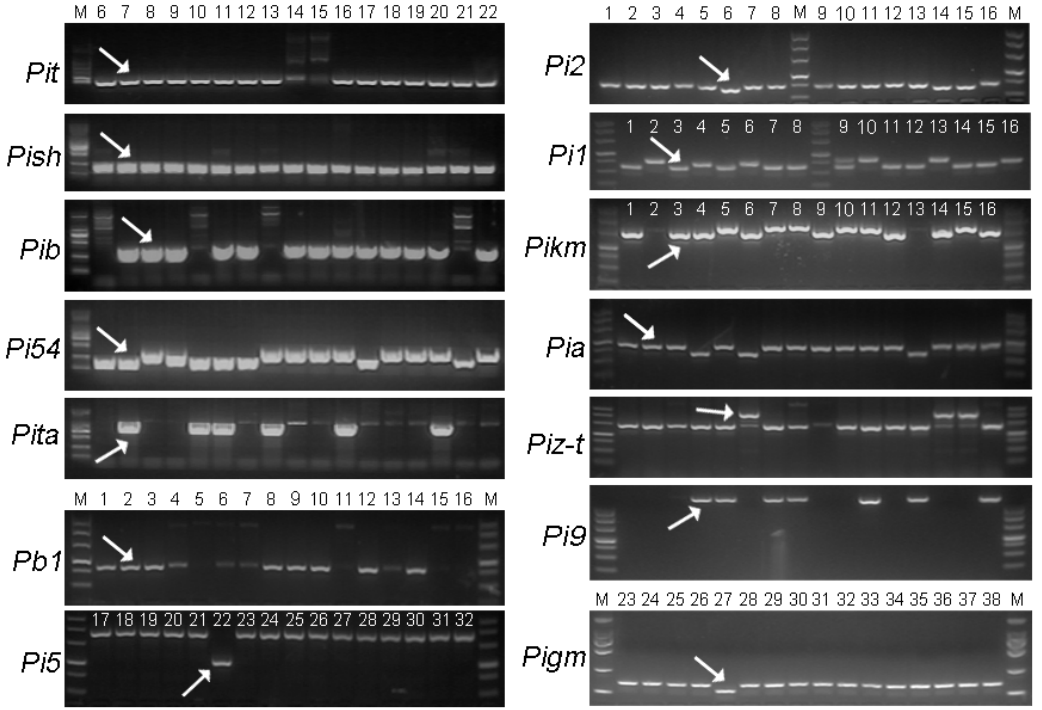
Figure 1. PCR amplification patterns of molecular markers that discriminate 14 R genes. The arrow- heads indicate positive stripe. The numbers were listed in Table S2. arrowheads indicate positive stripe. The numbers were listed in Table